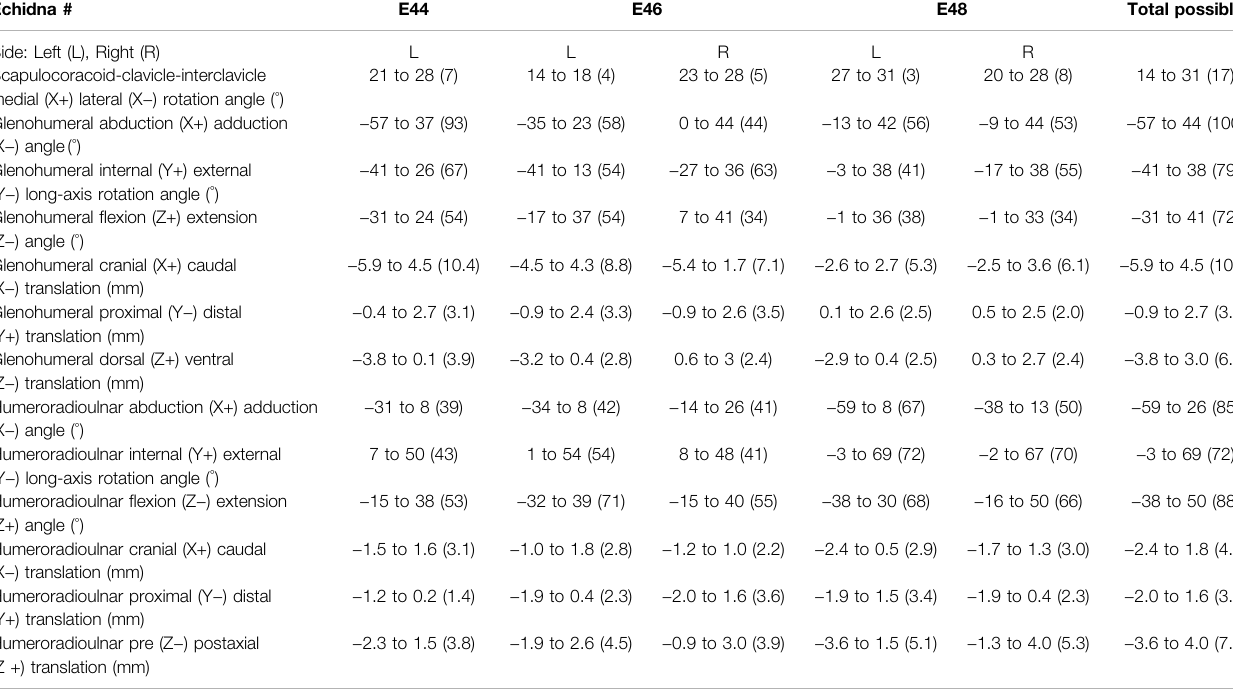
TABLE 1 | Raw, un-cosine-corrected values of experimentally-estimated rotations and translations at the echidna forelimb joints. Total joint ROM is in parentheses. Echidna # E44 E46 E48 Total